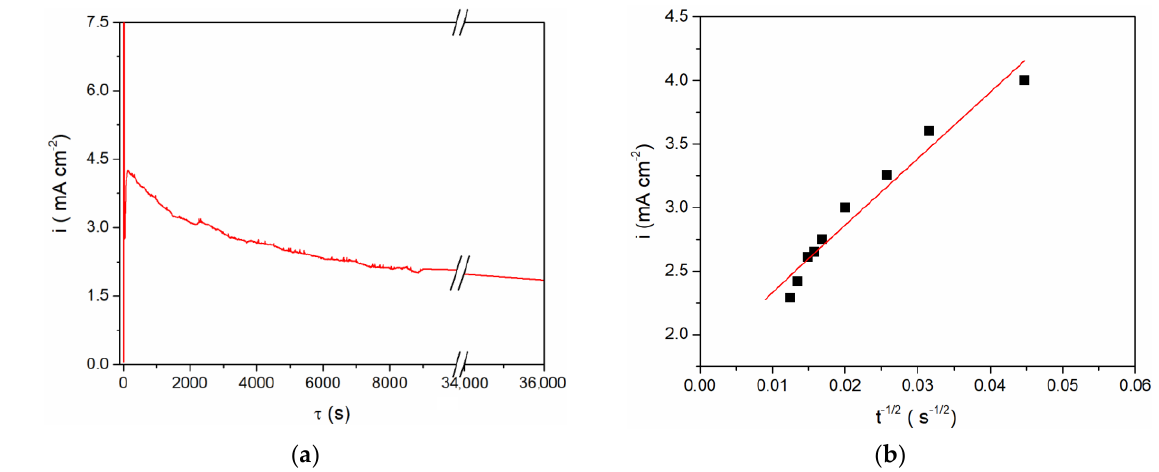
Figure 4. ( a ) Anodic dissolution of V working electrode at 1.300 V vs. Al for 10 h in equimolar melt AlCl 3 + NaCl, T = 200 °C; ( b ) i =f(t −1/2 ) for the falling part of the transient obtained during vanadium dissolution process presented in ( a ).